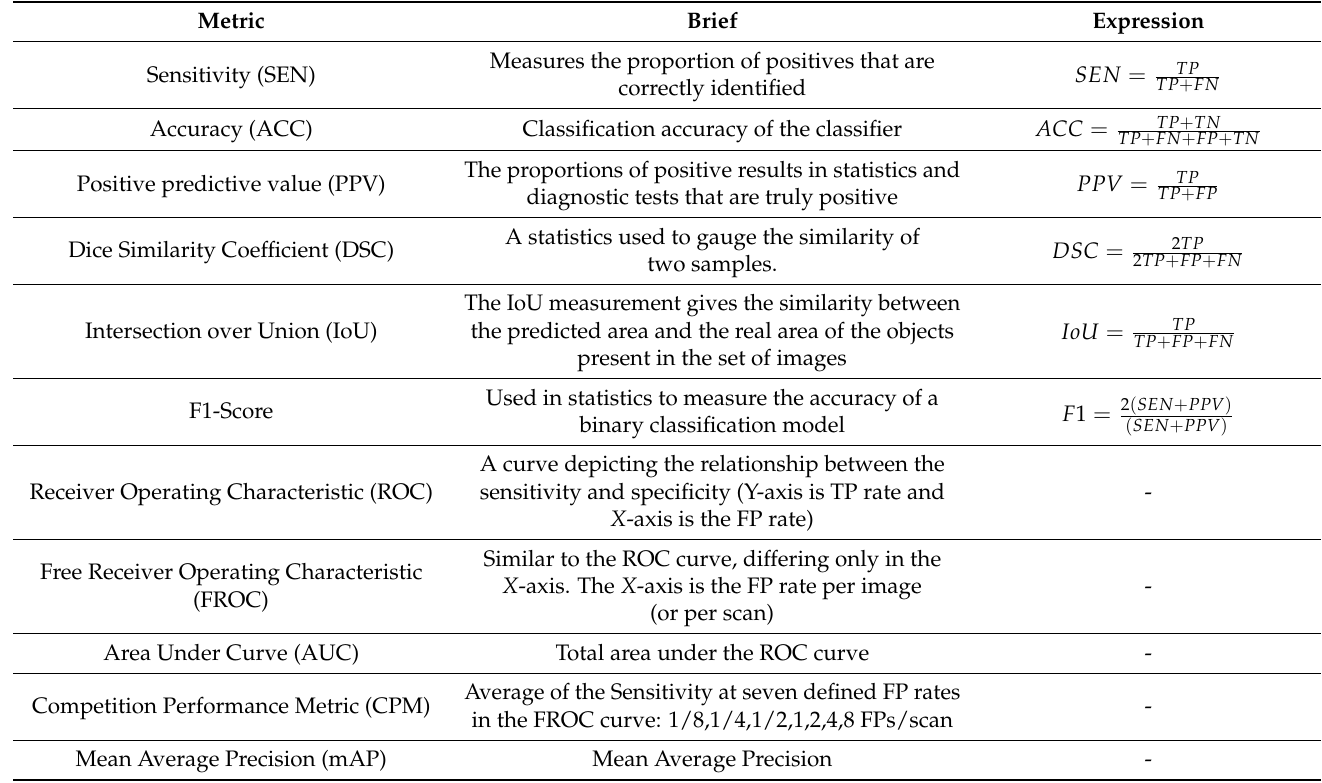
Table 2. Various evaluation metrics used for lung cancer/nodule